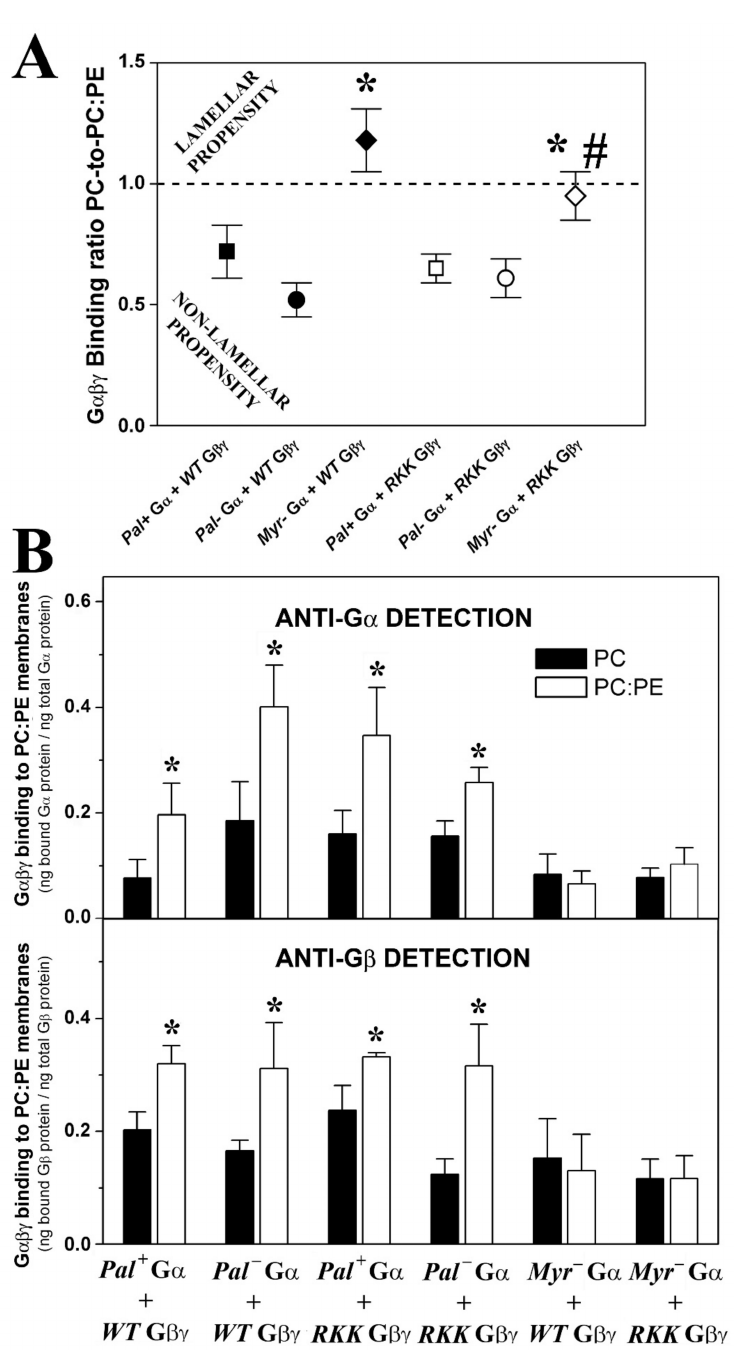
Figure 4. Effect of PE and G α i 1 and G γ 2 structures on G αβγ –membrane interactions. ( A ), Binding ratio PC-to-PC:PE corresponding to the different G α i 1 β 1 γ 2 heterotrimers generated and purified. The ratios are calculated considering the fractions of G α i 1 and G β 1 bound to PC relative to their corresponding fractions of binding to PC:PE (1:1, mol:mol) in each independent experiment. The data represent the mean ± S.E.M. values: * p < 0.05 with respect to Pal+ G α i 1 /WT G β 1 γ 2 ; # p < 0.05 with respect to Myr- G α i 1 /WT G β 1 γ 2 . ( B ), Binding of G α i 1 β 1 γ 2 heterotrimers to PC and PC:PE membranes. Bars show the mean binding of the heterotrimers to PC and PC:PE membranes calculated as the bound G α i 1 protein relative to total G α i 1 protein (upper panel) or bound G β 1 protein relative to total G β 1 protein (lower panel). It has to be noticed that palmitoylation is reversible, so that Pal- is not a mutant but a natural status of the monomeric and trimeric G protein forms. RKK: R62G-K64G-K65G. The data represent the mean ± S.E.M.: * p <